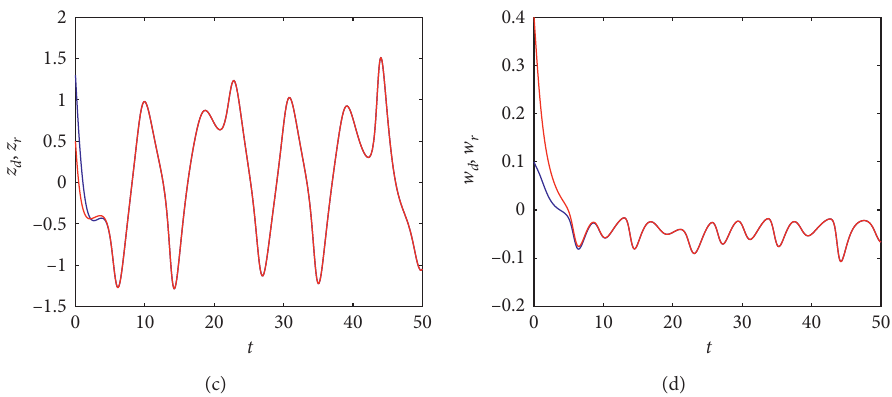
Figure 3: Time histories of drive system (2) (blue curve) and driven system (3) (red curve) under the control law given in Theorem